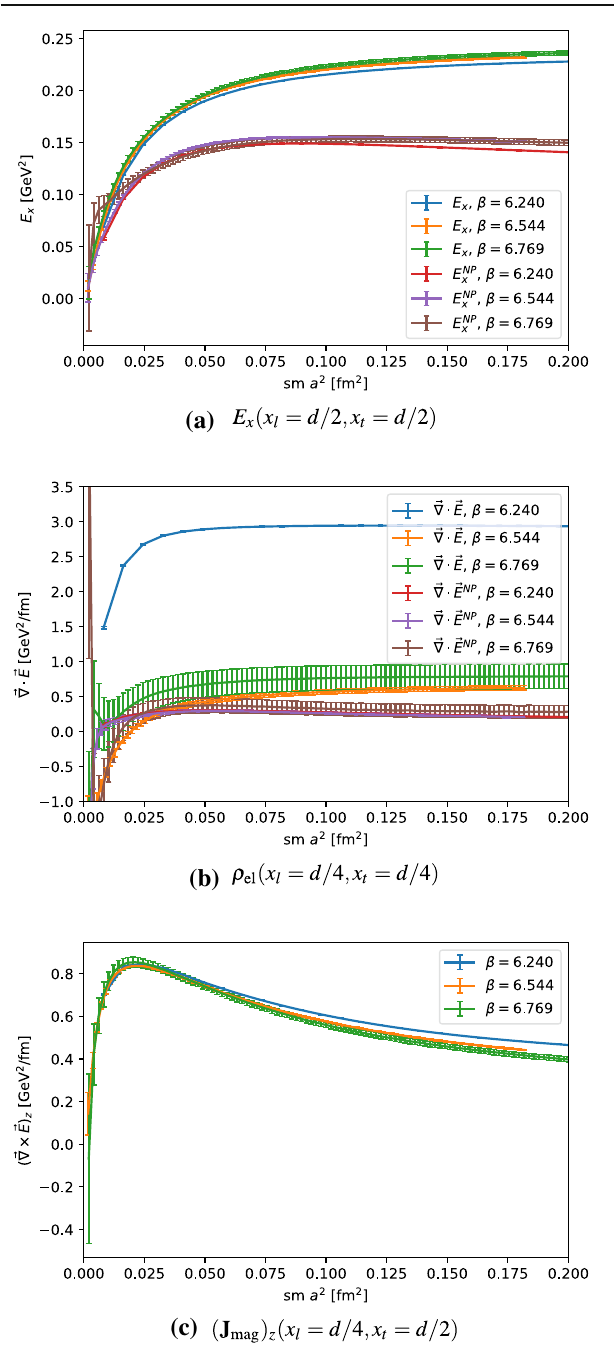
Fig. 3 Full and non-perturbative longitudinal electric field at x l = x t = d / 2 ( a ), full and non-perturbative electric charge density at x l = x t = d / 4 ( b ), and magnetic current density at x l = d / 4, x t = d / 2 ( c ) as functions of smearing